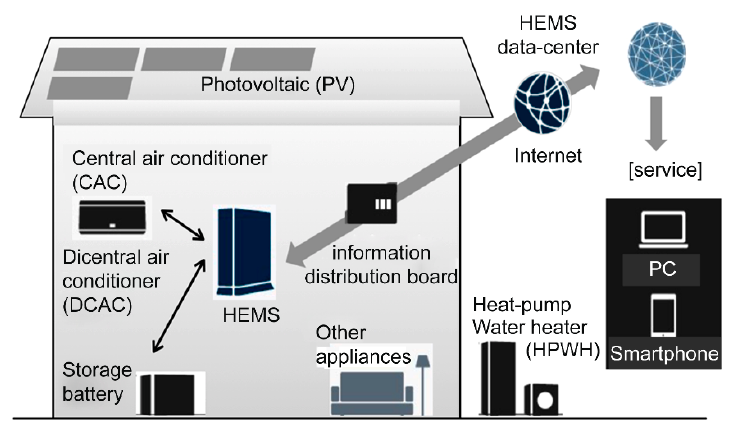
Figure 1. Configuration of home energy management system (HEMS). Table 1. Available HEMS data. (Data sources: Sekisui Chemical Co., Ltd., Housing Company.) Static Data